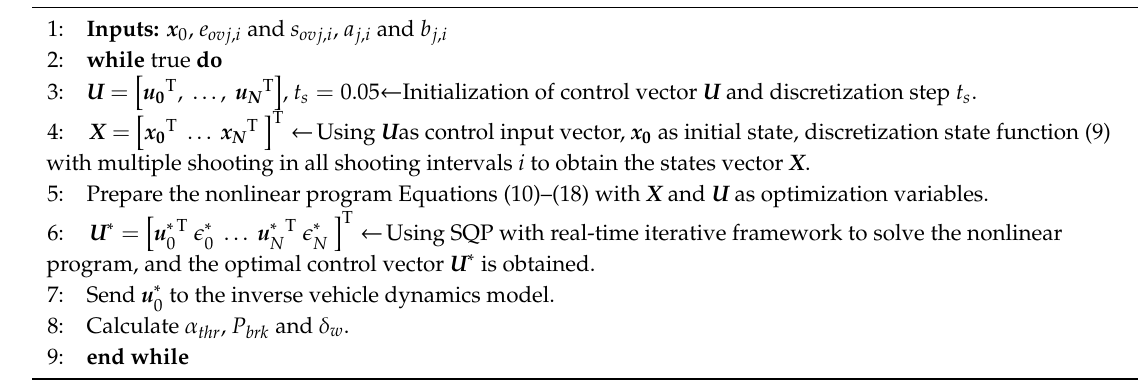
Algorithm 1 Outputs: Throttle α thr , brake P brk , steering wheel angle δ w